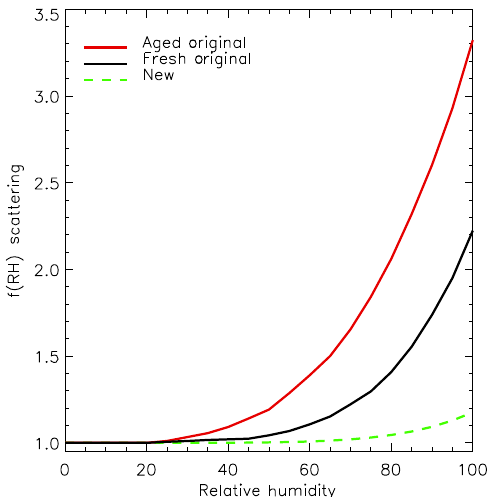
Figure 3. The f (RH) scattering curves used in the CLASSIC aerosol scheme for BBA. Red and black lines show the standard hygroscopic scattering behaviour for fresh and aged BBA, and the green dashed line shows values applied in this work, taken from Kotchenruther and Hobbs (1998) for Porto Velho,